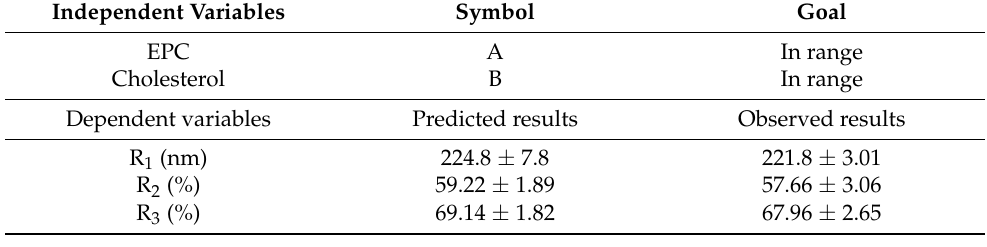
Table 3. Predicted and observed results of the optimized PEGylated Brucine liposomal formulation.